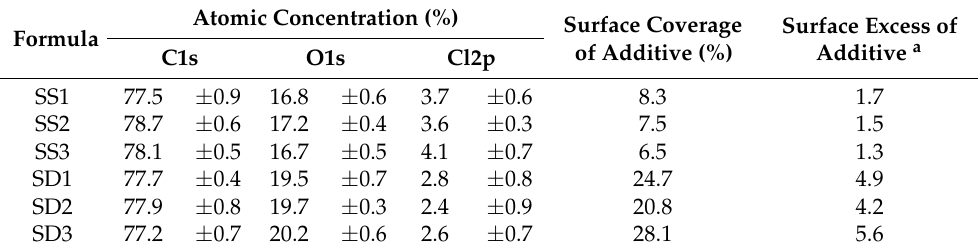
Table 4. Atomic concentrations (%) determined by XPS for six different composite particles (mean ± S.D., n =